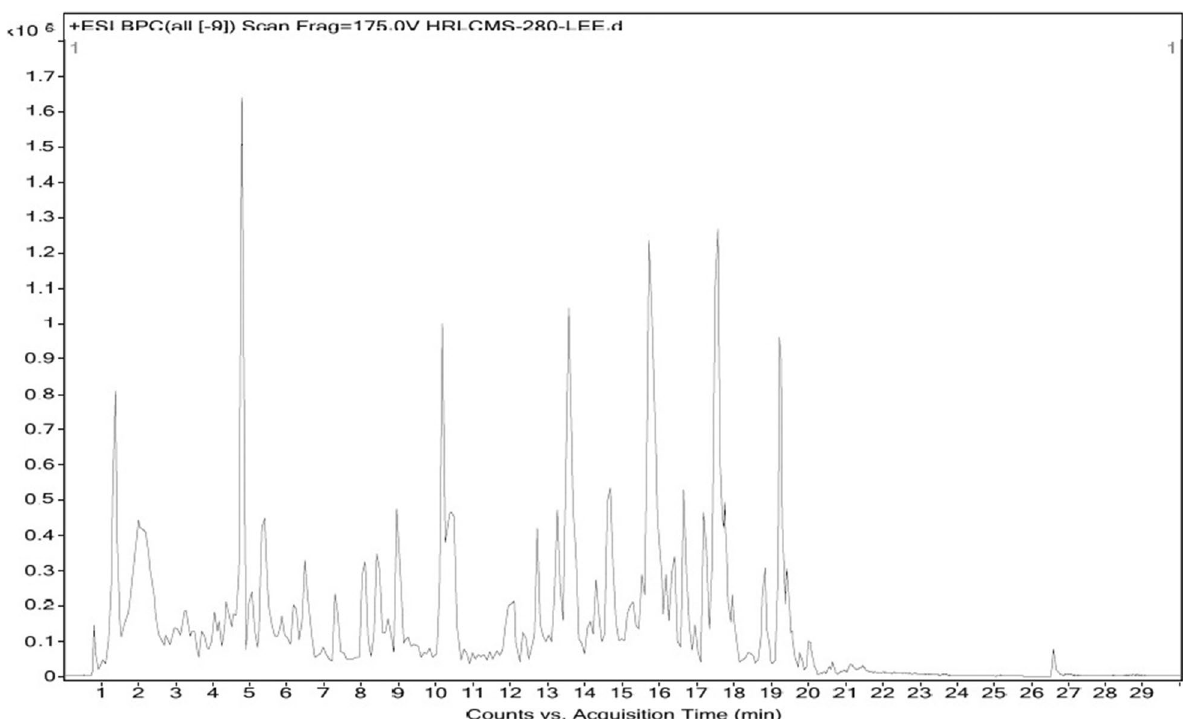
Fig. 3 Identification of perlolyrine by LC–MS